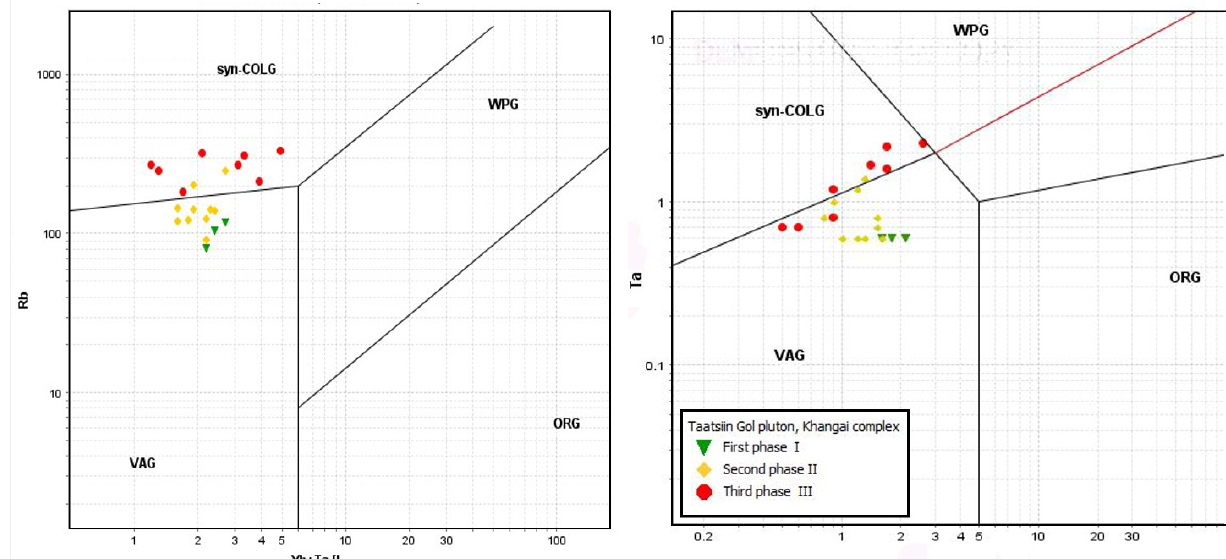
Fig 17. Tectonic discrimination diagram of the granite samples from Taatsiin Gol pluton, Khangai Complex (Pearce et al., 1984); syn-COLG-collision, WPG- within-plate, ORG-orogenic granite, VAG-volcanic arc granite